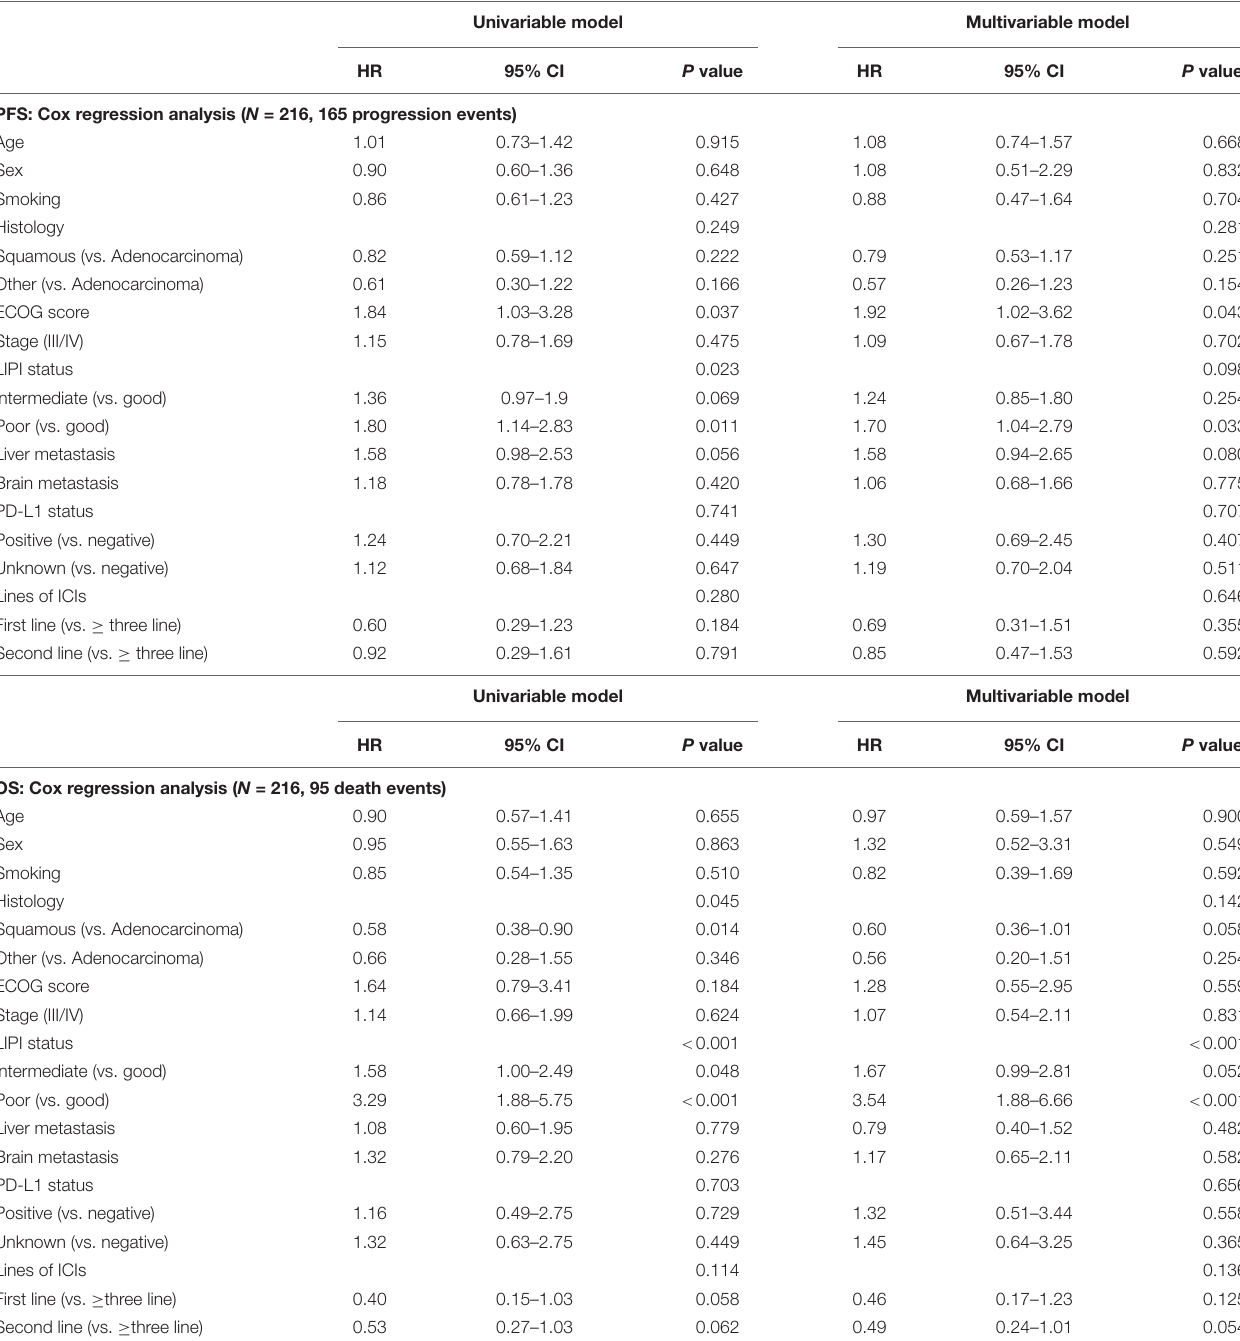
TABLE 2 | Univariable and multivariable analyses of progression-free survival (PFS) and overall survival (OS) in patients with ICIs monotherapy. Univariable model Multivariable